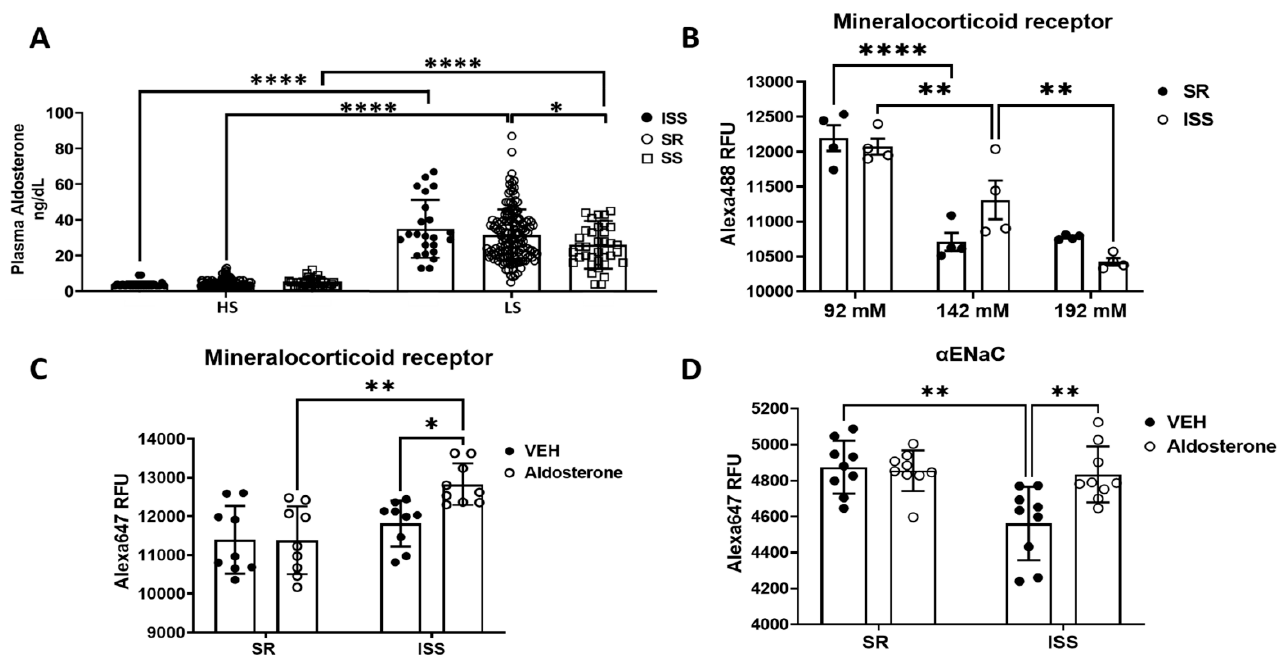
Figure 7. Aldosterone level from our dietary salt study and aldosterone treatment on urine-derived renal tubule cells. ( A ) Plasma aldosterone level of ISS, SR and SS participants on low- and high-salt diets (ISS HS, 3.8 ± 0.38, n = 26; ISS LS, 35 ± 3.38, n = 22; SR HS, 4.34 ± 0.18, n = 180; SR LS, 32.62 ± 1.6, n = 152; SS HS, 4.65 ± 0.35, n = 43; SS LS, 26.08 ± 2.18, n = 38; HS vs. LS, p < 0.001, two-way ANOVA, Tukey’s multiple comparisons test). ( B ) MR level under different sodium treatments in both SR and ISS cells (SR, 92 mM 12194 ± 183 vs. 142 mM 10708 ± 129; ISS, 92 mM 12072 ± 112 vs. 142 mM 11309 ± 277; n = 4/group, p < 0.01, two-way ANOVA, Dunnett’s multiple comparisons test). ( C , D ) Mineralocorticoid receptor (MR) and α ENaC level under aldosterone treatment (1 µM) on both SR and ISS cells (MR: ISS VEH 11818 ± 197 vs. ISS Aldosterone 12835 ± 178, n = 9/group, p < 0.05; α ENaC: ISS VEH 4561 ± 68 vs. ISS Aldosterone 4834 ± 52, n = 9/group, p < 0.01, two-way ANOVA, Tukey’s multiple comparisons test). * p < 0.05, ** p < 0.01, **** p < 0.001.